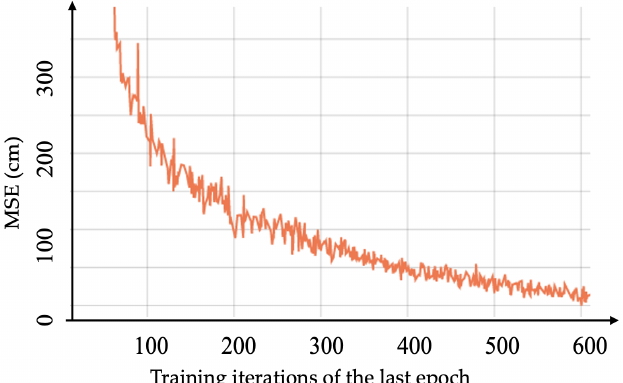
Figure 4. Mean squared error(MSE) of our pose regression model in the last (5th) epoch.